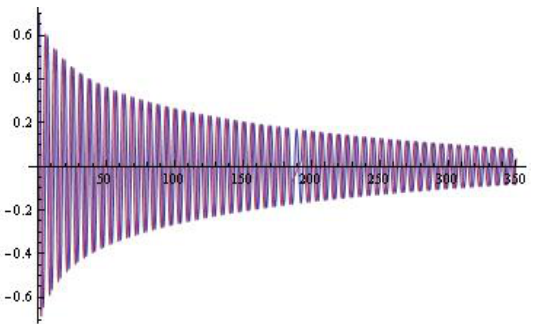
Figure 10. P ( r 2 ,4 ) for n = 9 and µ 1 = 9.0482691 . . .. The simple roots are 0.338954, 0.987437 and root 0.75243—with multiplicity 2.